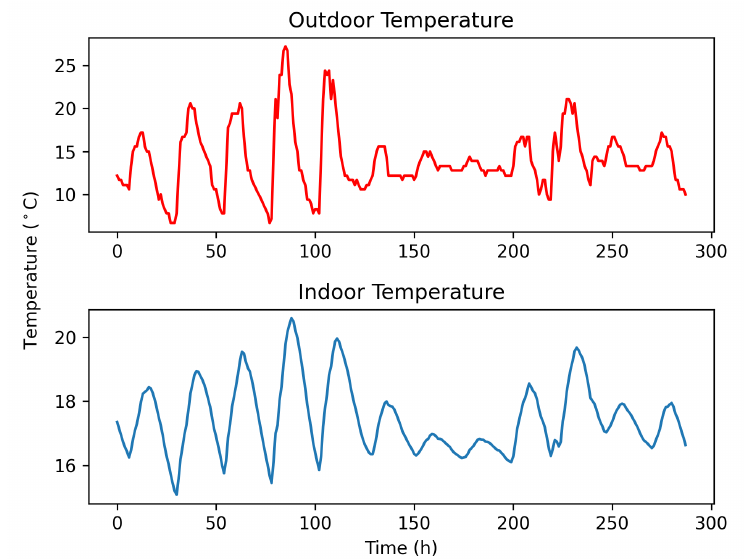
Figure 3. Hourly indoor-outdoor simulation temperature data during 2/26 to 3/09.